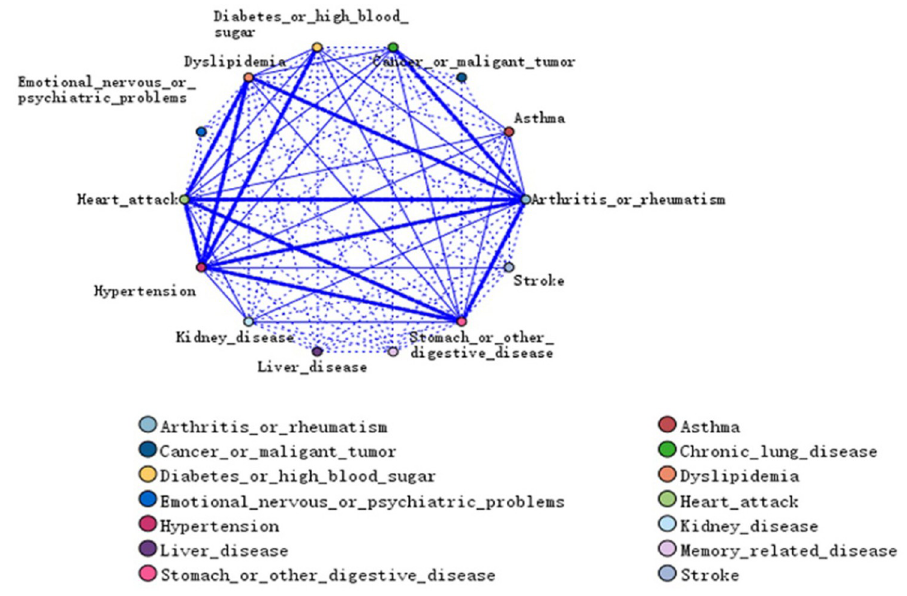
Fig 1. A web graph of associations between chronic